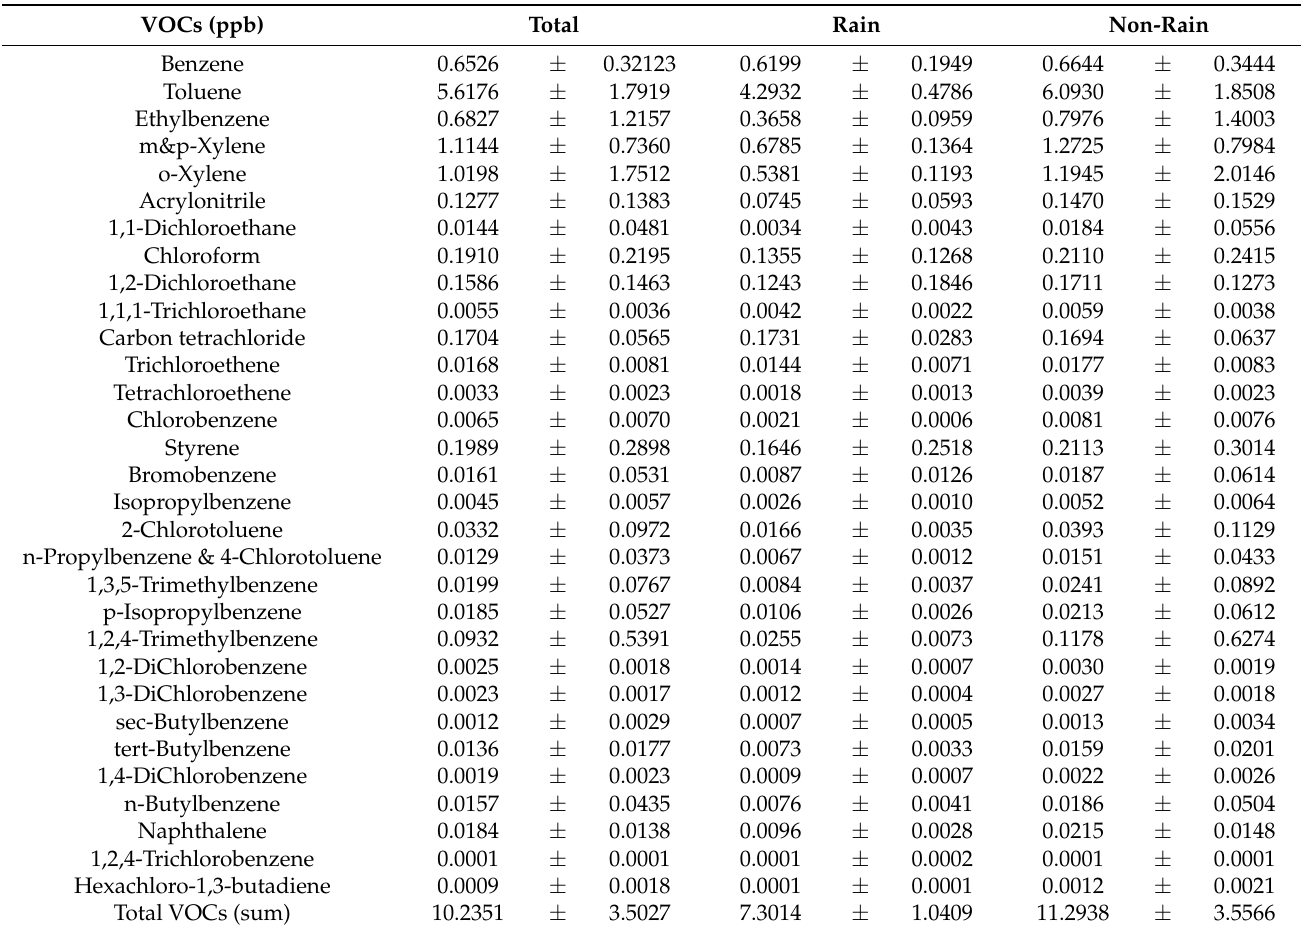
Table 3. Analysis result of VOCs concentration in the orchard